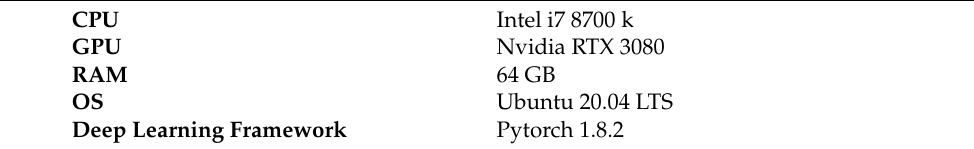
Table 6. Specifications and environmental setup of the GPU